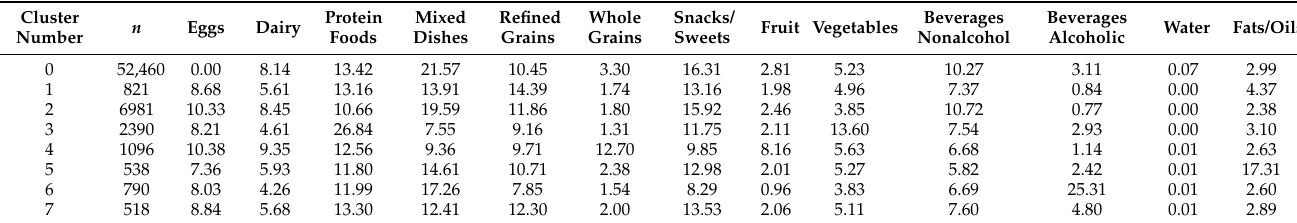
Table 3. Egg dietary patterns of consumption (clusters) and mean percent calories (kcal) within food groups. Cluster